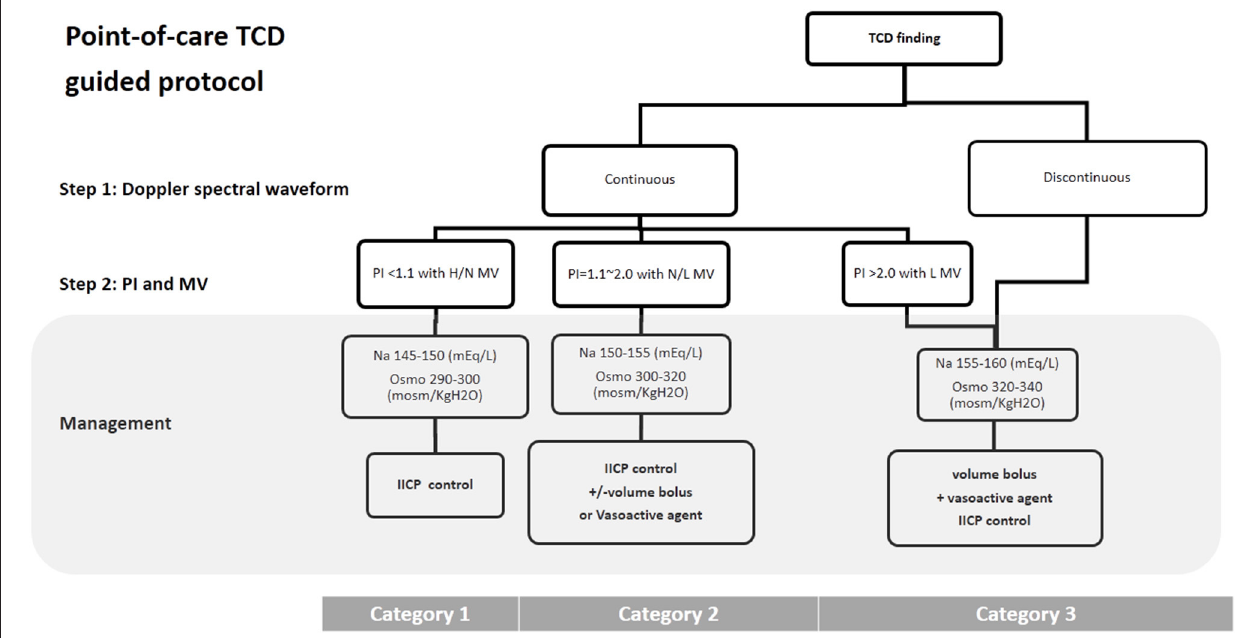
FIGURE 3 | TCD guided cerebral resuscitation protocol. A stepwise management algorithm shows the clinical treatment strategy according to the pattern of Doppler spectral waveform, PI and MV of middle cerebral artery on TCD examination. H, high; N, Normal; L, low; IICP, increased intracranial pressure; TCD, Transcranial Doppler ultrasound; PI, pulsatility index; MV, mean velocity; Osmo,